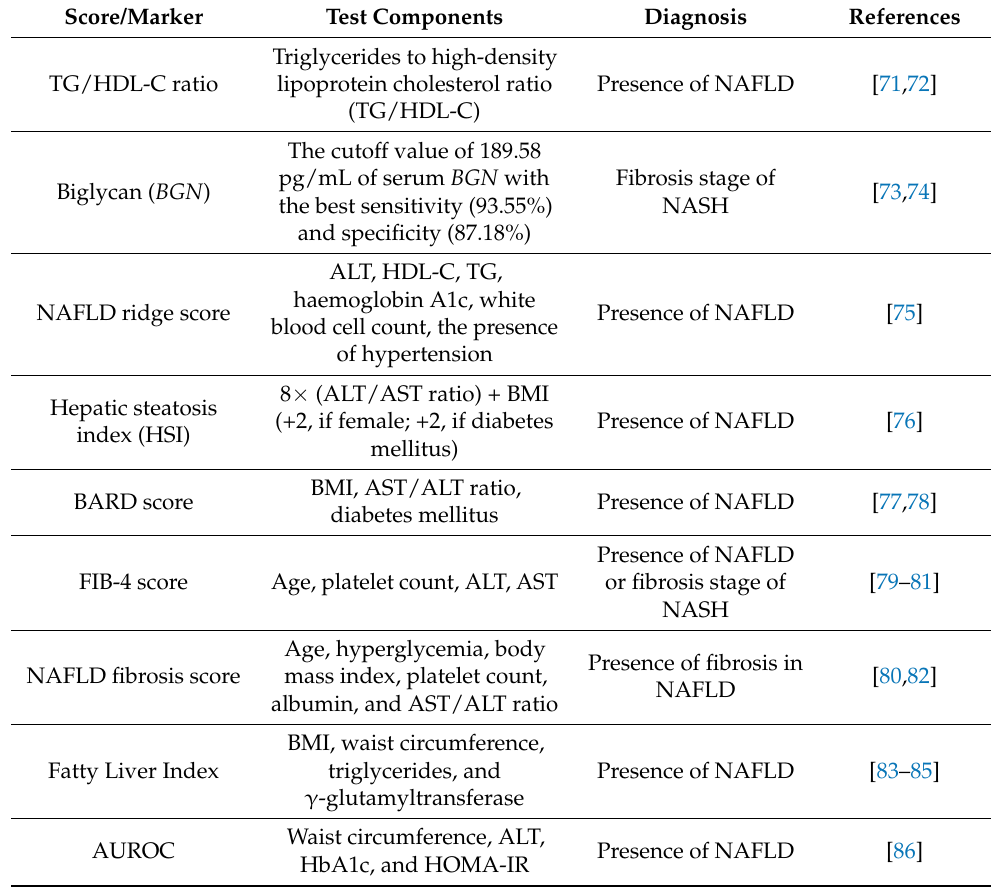
Table 2. Serum markers and score system for NAFLD and NASH diagnosis. Score/Marker Test Components